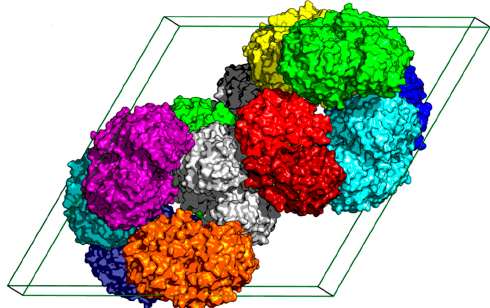
Figure 1. Crystal packing of St Chi40 molecules. The two molecules in each asymmetric unit are shown in the same color. In the pair of molecules colored red, the two monomers are distinguished by different shades. The unit cell is shown as a black box.